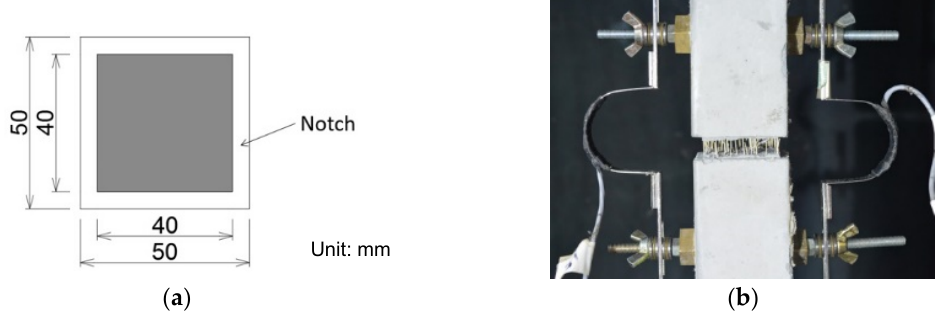
Figure 15. Uniaxial tension test specimen: ( a ) Dimensions of cross-section; ( b ) Specimen at loading.